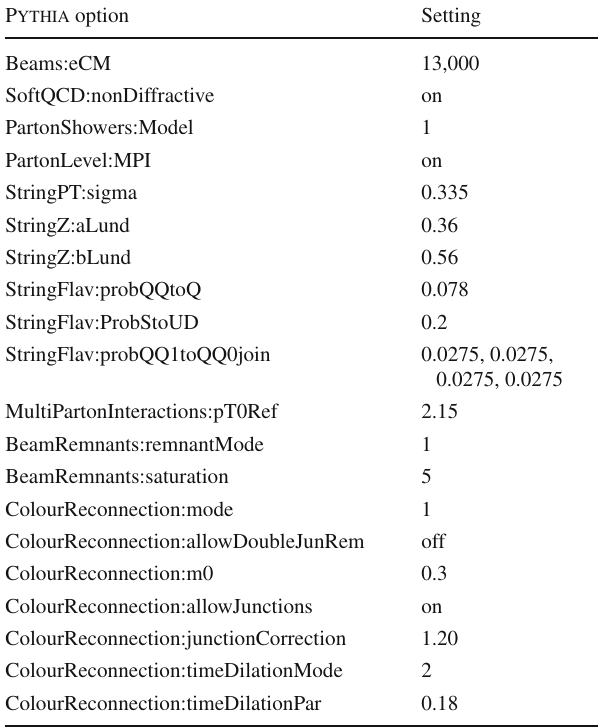
BcVegPy c meson as generated with